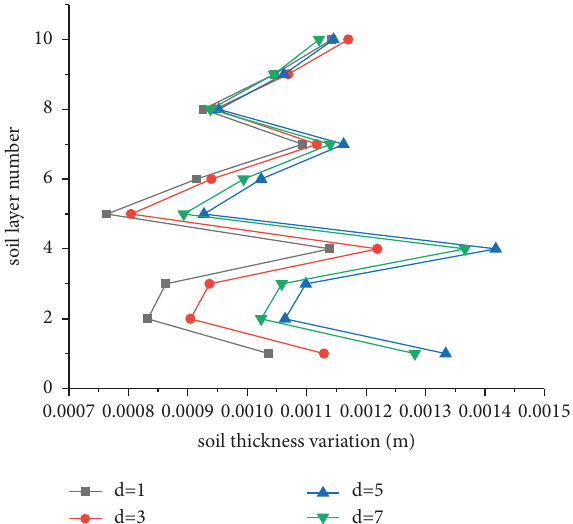
Figure 15: Variation in the thickness of each soil layer at diferent times at point A of the reinforced soil embankment.